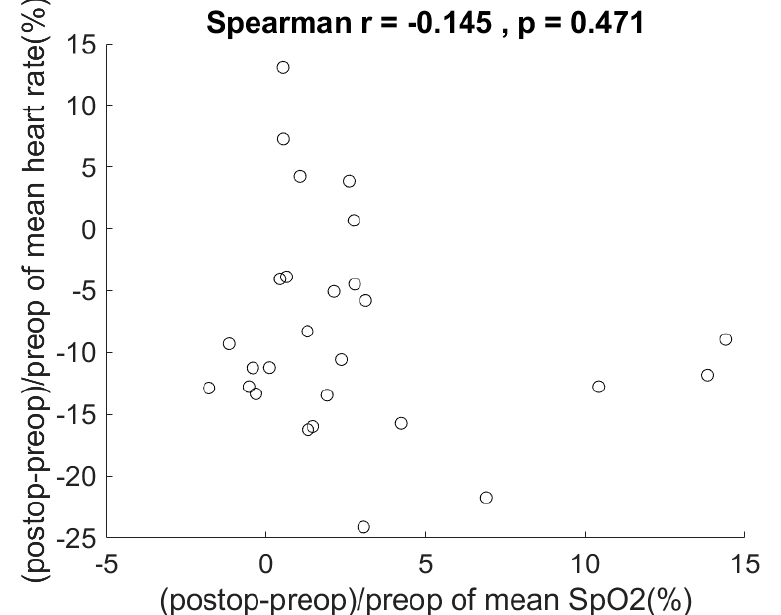
Figure 7. Scatter plot and correlation of change in mean SpO2 (defined here as (postoperative–preoperative)/preoperative mean SpO2) vs. change in mean heart rate (defined here as (postoperative–preoperative)/preoperative mean heart rate). This shows that the change in mean heart rate was not related to the change in mean SpO2.